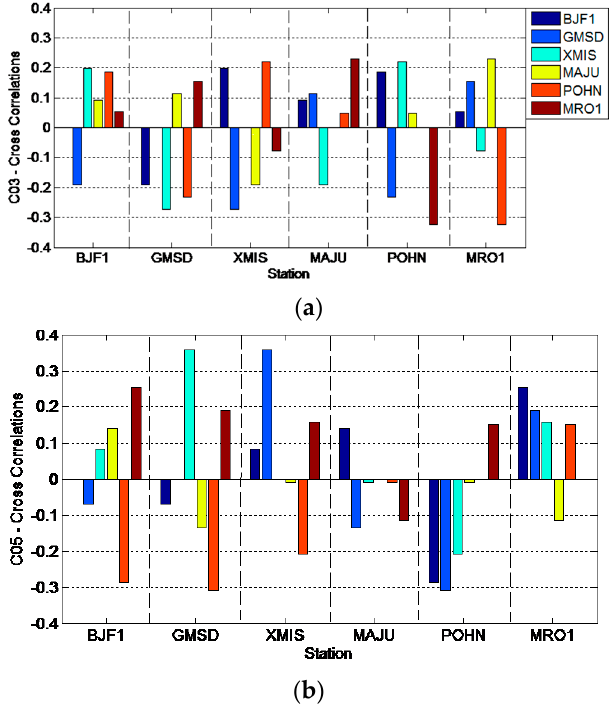
Figure 9. The Spearman cross-correlations between multipath biases at different stations for satellites C03 ( a ) and C05 ( b ).